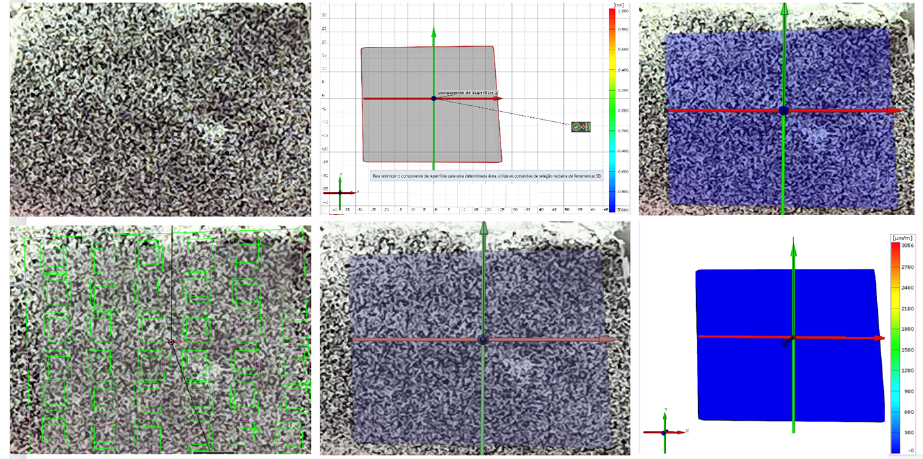
Figure 18. Analysis of DIC in 2D is divided into sections where they are then visualized in the next